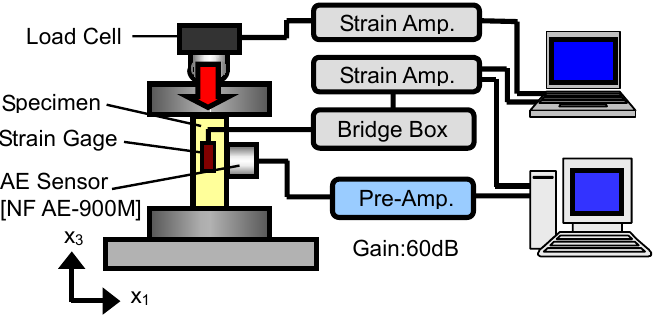
Fig. 2. Schematic diagram of static compression test system.